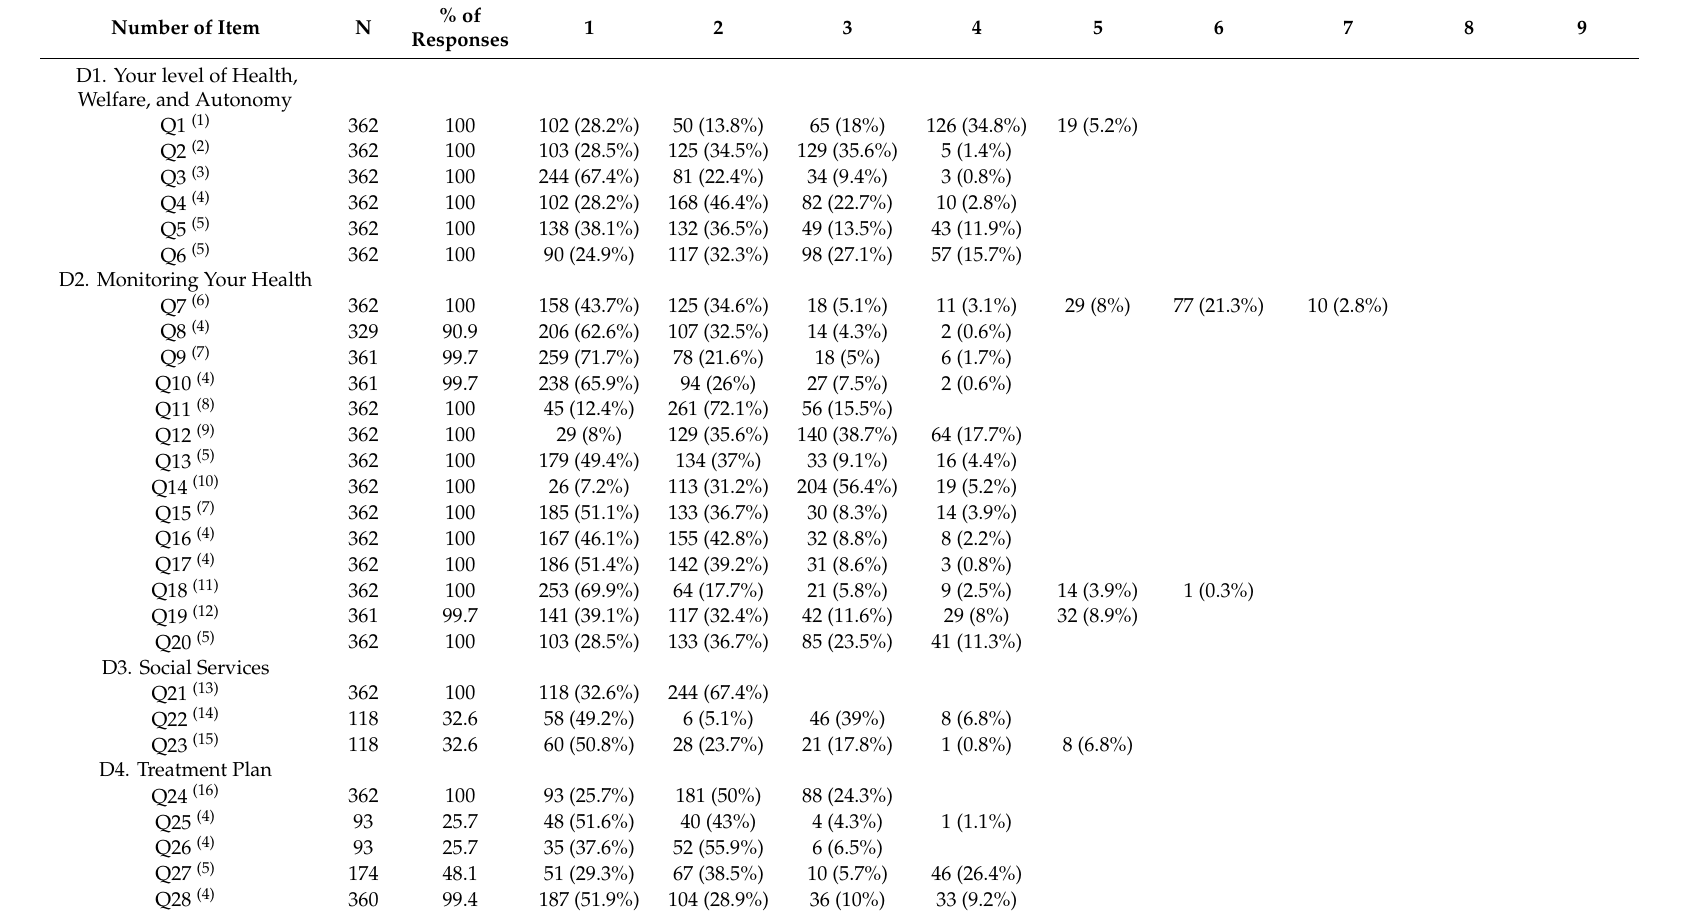
Table 2. Frequencies of the categories for the